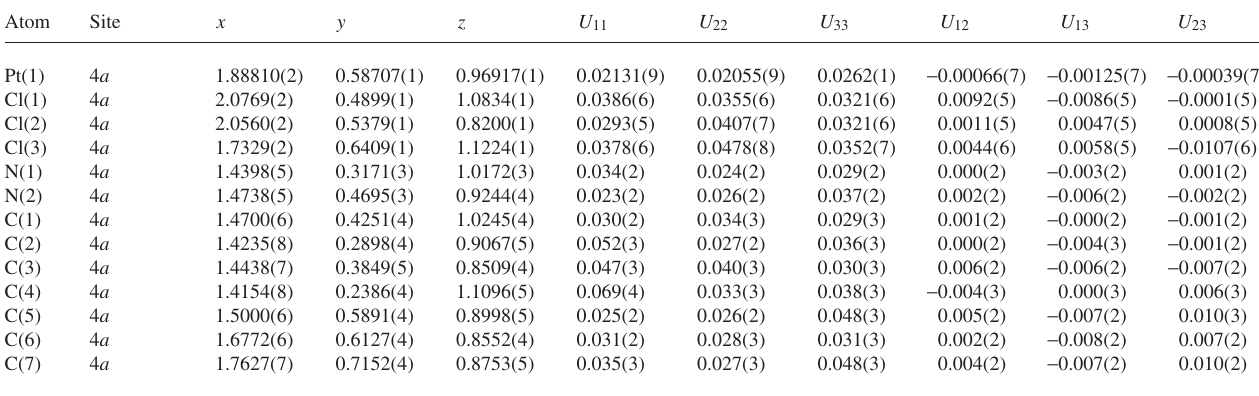
Table 3. Atomic coordinates and displacement parameters (in Å 2 )